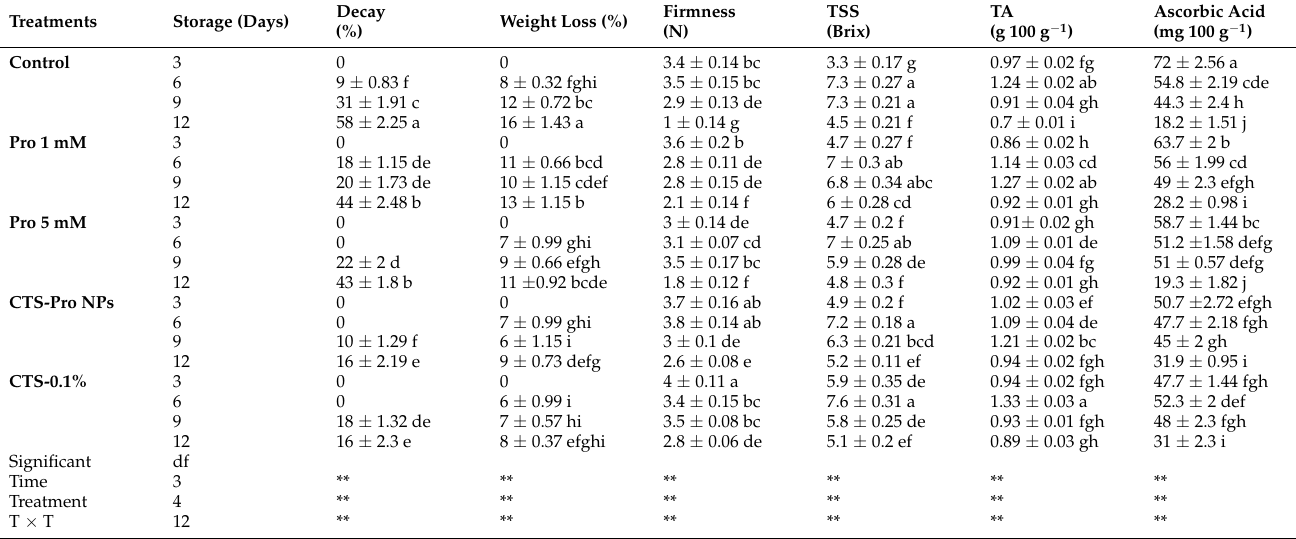
Table 1. Effect of post-harvest treatments of strawberries with Pro, CTS and CTS-P NPs on decay, weight loss, firmness, TSS, TA and ascorbic acid content during 12 days of storage at 4 ◦ C. Data shown are mean values of n =